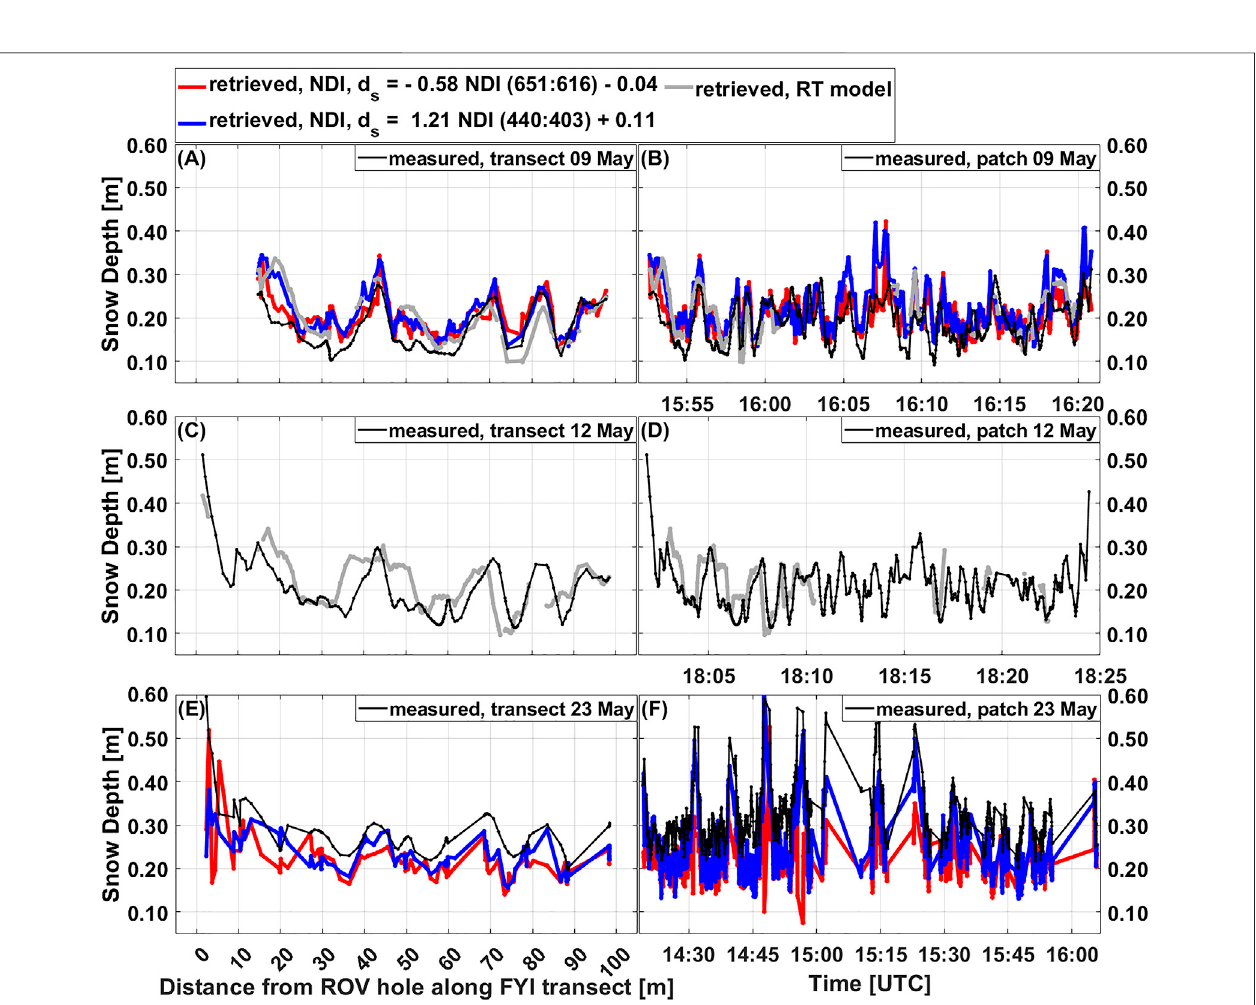
FIGURE 6 | Measured snow depth (black) and retrieved snow depth using the NDI method (red, blue) and the RT model (grey) along the transect (A,C,E) and across the patch (B,D,F) . Note that for the patches the x -axis is time.